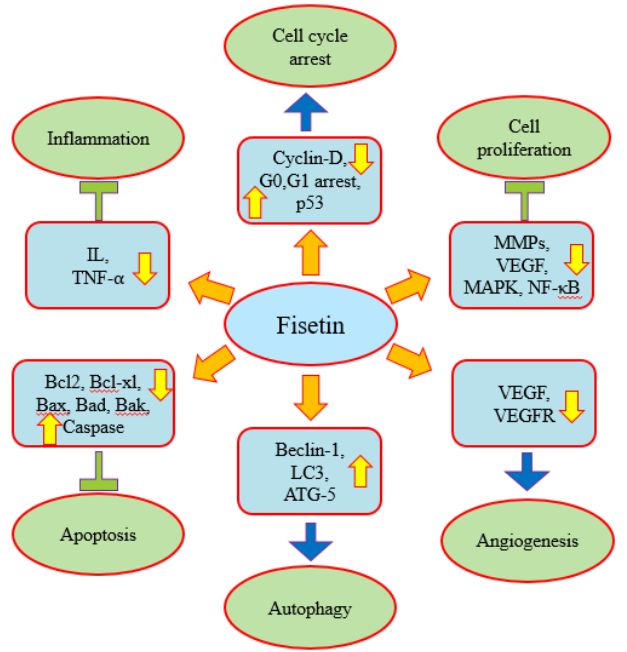
Figure 3. Anti-cancer potential of fisetin through the modulation of cell-signaling pathways.